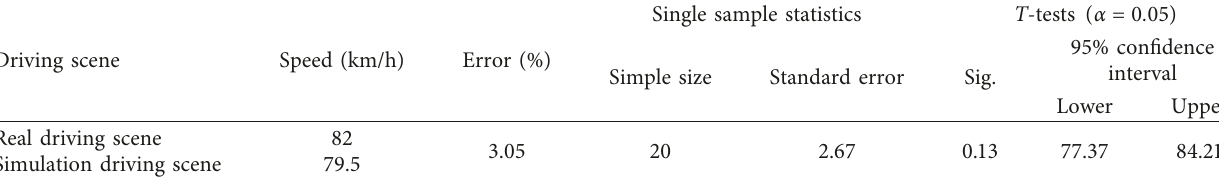
Table 1: Validation of model